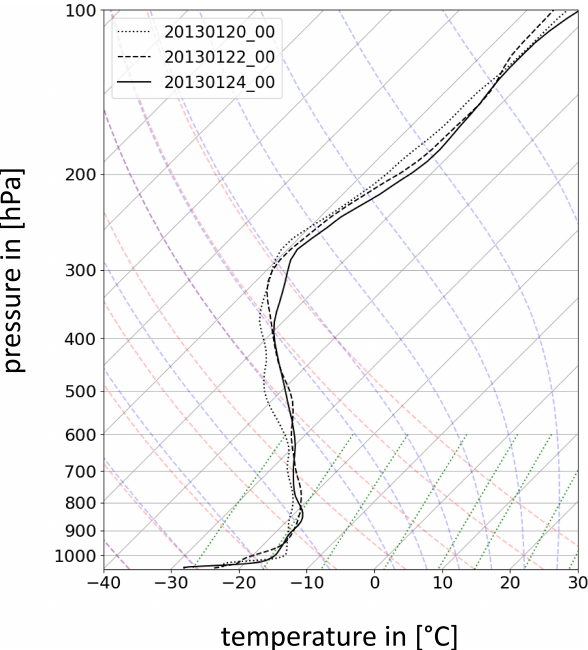
Figure 16. Skew T –log p diagram at 78.5 ◦ N, 173 ◦ E (black star in Fig. 15). Temperature is shown along the x axis (in ◦ C) and pressure along the y axis (in hPa). Black lines show the ambient temperature profile for 20 January 2013 (day 51; dotted line), 22 January 2013 (day 53; dashed line) and 24 January 2013 (day 55; solid line) at 00:00UTC. Grey lines show isobars (horizontal) and isotherms (skewed), respectively. Colored dashed lines denote dry (red) and moist (blue) adiabats, respectively. Green dotted lines denote con- stant saturation mixing